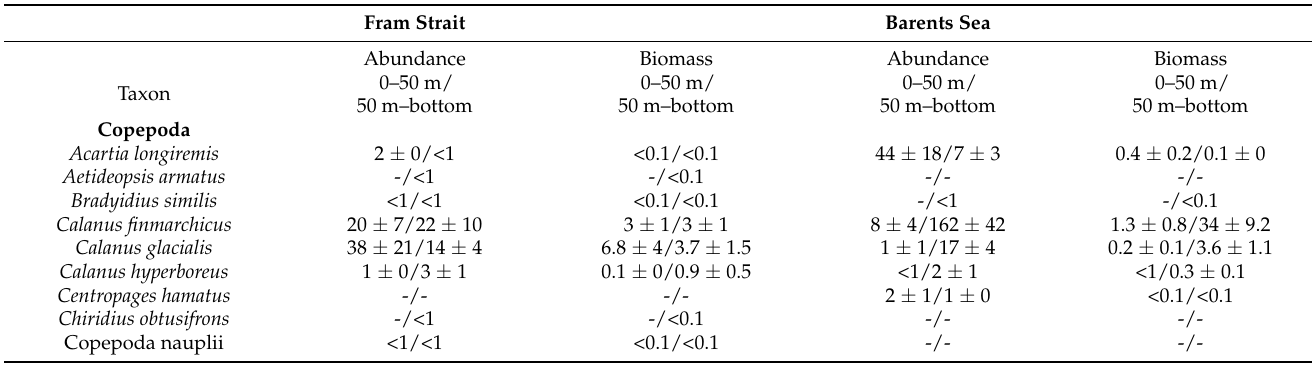
Table 2. Zooplankton abundance and biomass in the Fram Strait and in the Southern Barents Sea, winter